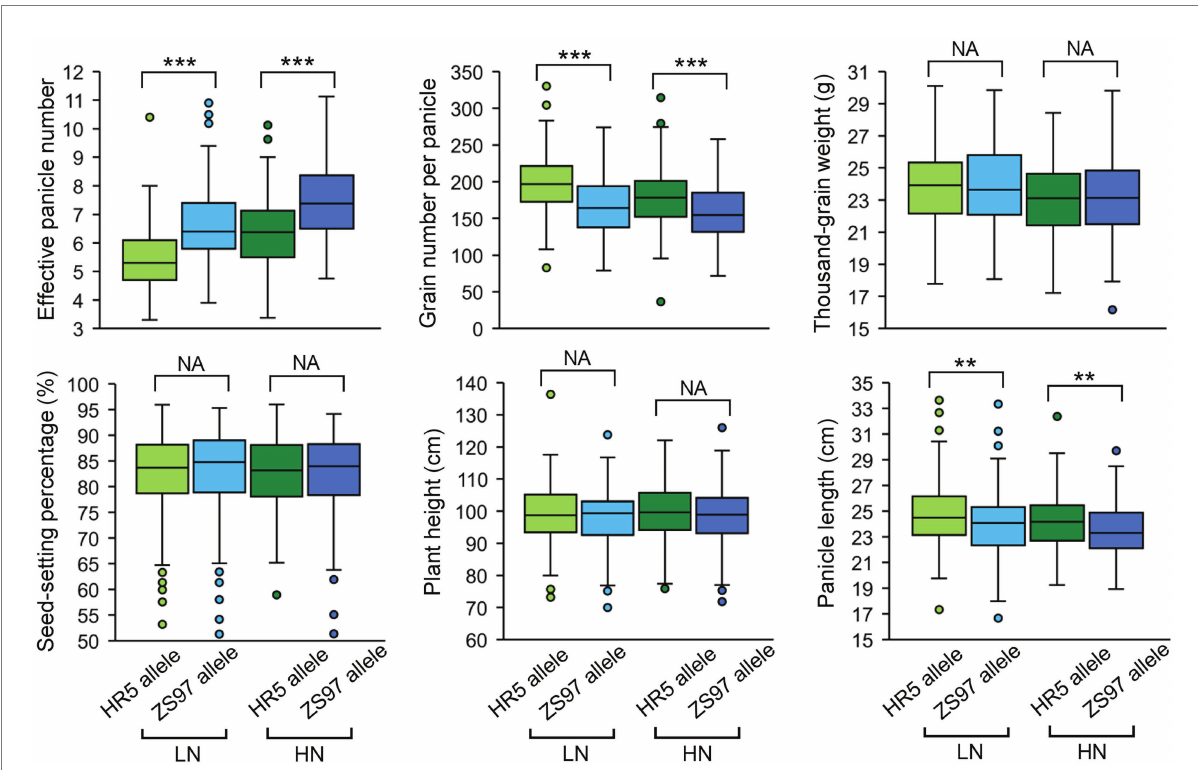
FIGURE 4 Performance of the qEPN-LN4 / qEPN-HN3 alleles in the RIL population. *** p < 0.001, ** p < 0.01; NS, not significant. LN, low nitrogen; HN, high